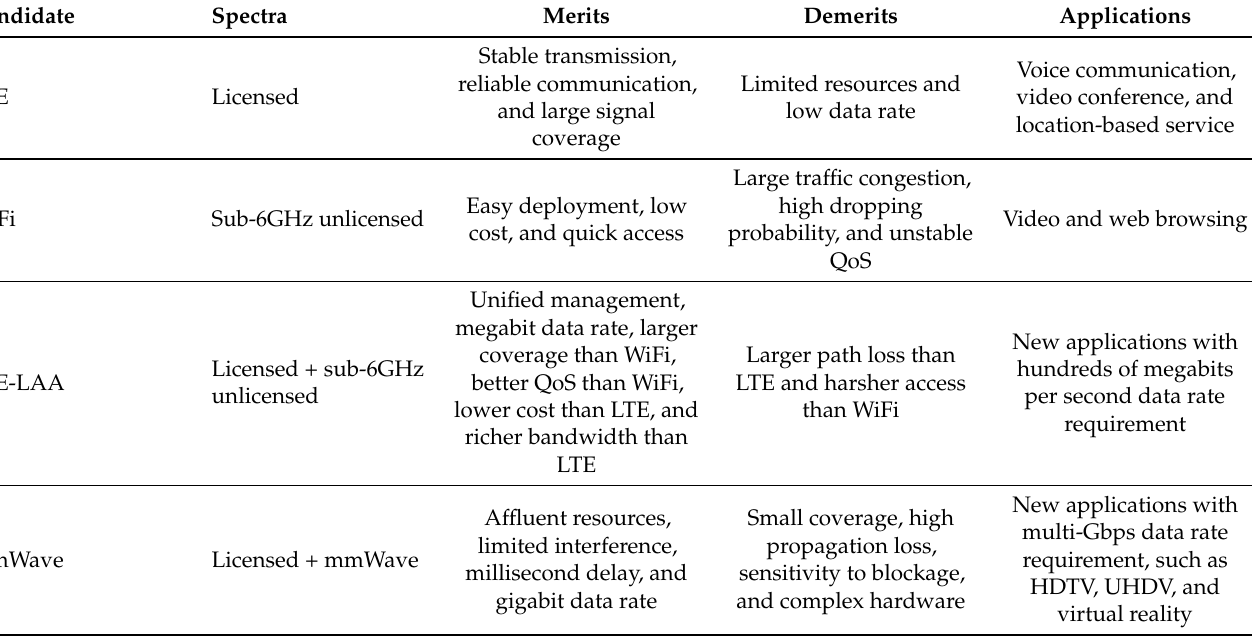
Table 1. Comparison of different